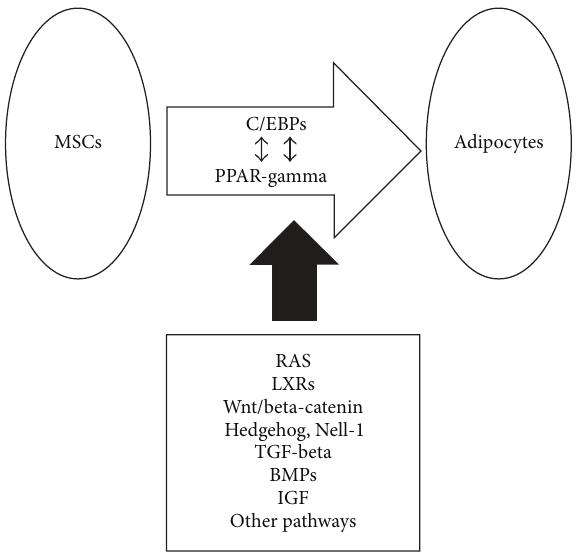
Figure 1: Overview of the established and potential regulatory mechanisms/pathways underlying MSC adipogenesis. A number of cellular signaling mechanisms/pathways control MSC adipogenesis, with the majority converging to regulate a range of transcription factors such as members of the CCAAT/enhancer-binding family of proteins (C/EBPs) and peroxisome proliferator-activated receptor- gamma (PPAR-gamma). Several of these mechanisms/pathways are likely to operate simultaneously; however, the full scope of mecha- nisms/pathways influencing MSC adipogenesis remains unknown. BMPs, bone morphogenetic proteins; IGF, insulin-like growth factor;LXRs,liverXreceptors;MSCs,mesenchymalstemcells;RAS, renin-angiotensin system; and TGF, transforming growth